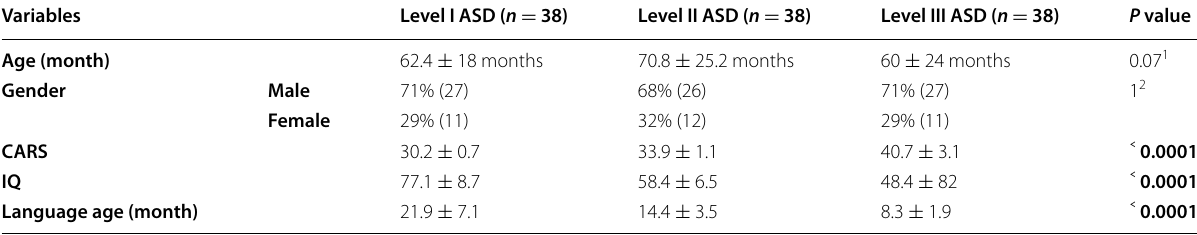
Data are expressed as mean 1 P value was generated by Kruskal–Wallis one-way test 2